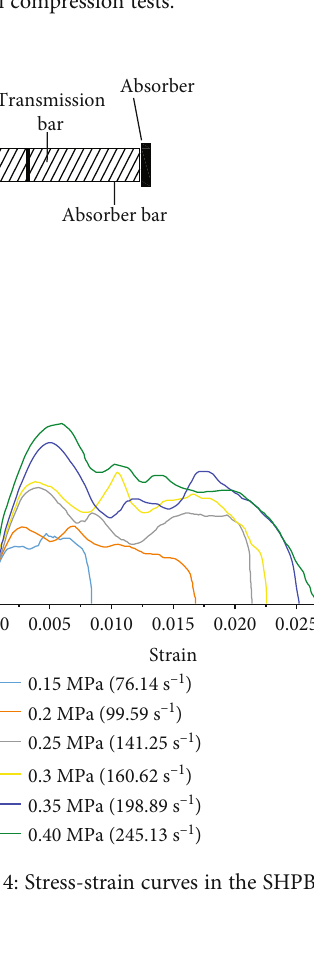
Figure 2: Failure patterns of granite samples after uniaxial compression tests.